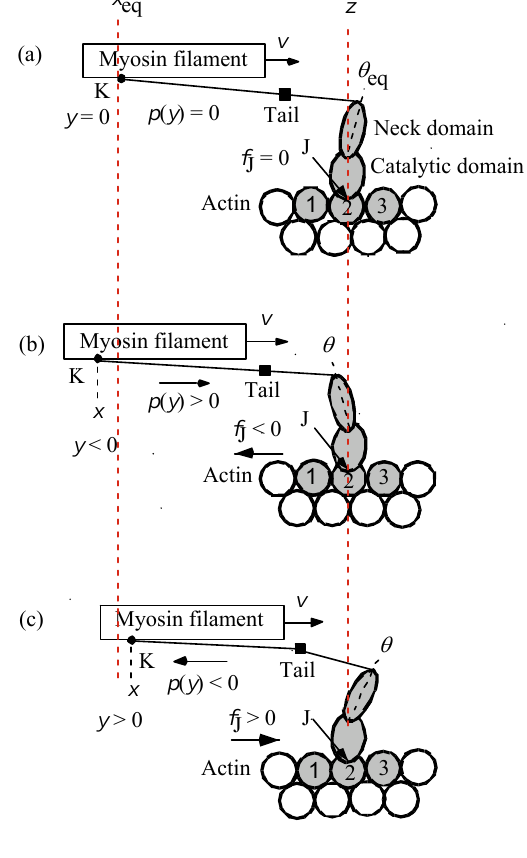
Figure 4. Definition of y , the shortening of the crossbridge: y = x − x (after Figure 4 of [2]). eq The binding positions J are set on the dotted red line z . (a) The myosin head is at its equilibrium angle,  . x = x and y = 0; (b) The myosin head is pulling the myosin eq eq filament forward. The crossbridge is elongated and y < 0; (c) The myosin head is pushing the myosin filament backward. The crossbridge is shortened and y >